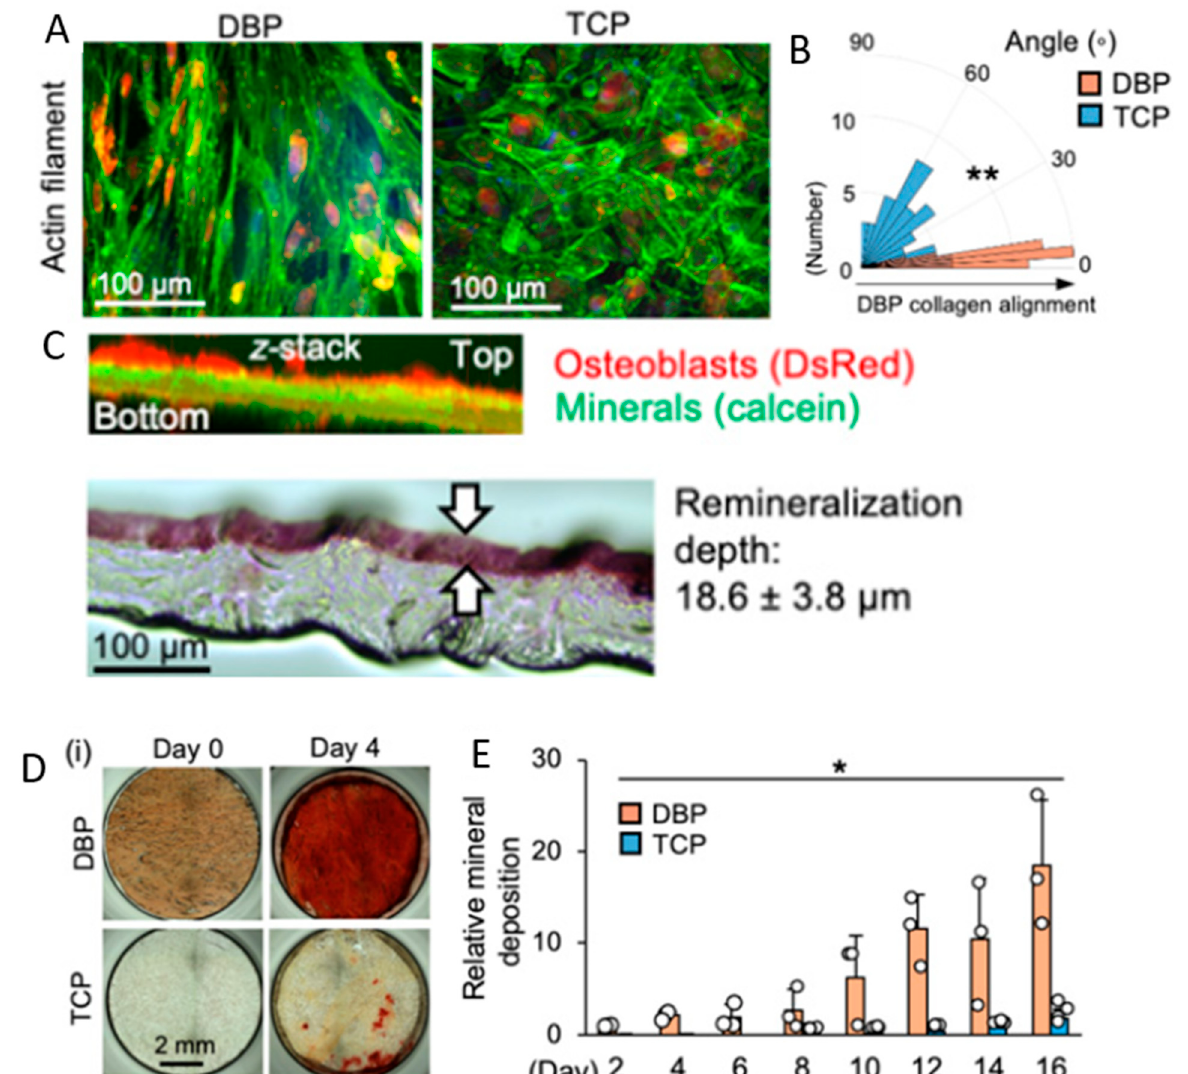
Figure 4. Osteoblasts grown on demineralized bone paper (DBP) display enhanced regenerative capacities compared to osteoblasts grown on tissue culture polystyrene (TCP). ( A ) Morphology of OBs grown on vertically sectioned DBP and TCP for one week. ( B ) Immunofluorescent staining of actin filaments. ( C ) Circular histogram of cell alignment angles ( n = 100). ( C ) Top: z -staked cross-sectional image of DBP will osteoblasts growing. Bottom: Cross section of 100- µ m-thick DBP stained with alizarin red after three-week culture of osteoblasts ( n = 3). ( D ) Mineral deposition by osteoblasts on DBP and TCP, showing alizarin red mineral stain on days zero and four. ( E ) Time-course measurement of mineral deposition by osteoblasts for 16 days ( n = 3). * indicates p -value < 0.05; ** indicates p -value < 0.01. Figure adapted with permission under a Creative Commons Open Access License from Park et al., 2021